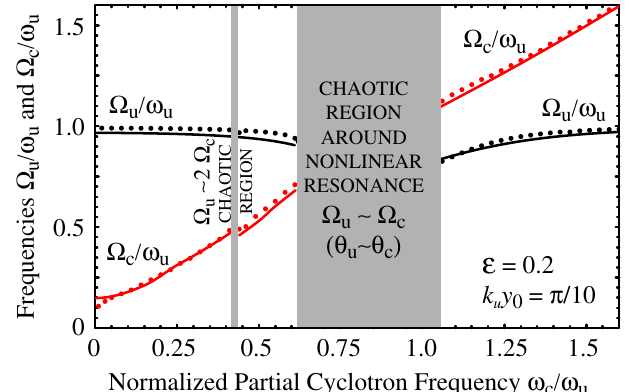
FIG. 2. The normal undulator and cyclotron frequencies vs the normalized partial cyclotron frequency. Solid lines are for the analytical results, while dots correspond to the results of the numerical simulation. In the numerical simulations the adiabatic undulator entrance is taken into account.